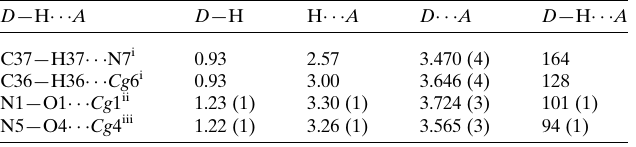
Table 2 Experimental details. Crystal data Chemical formula